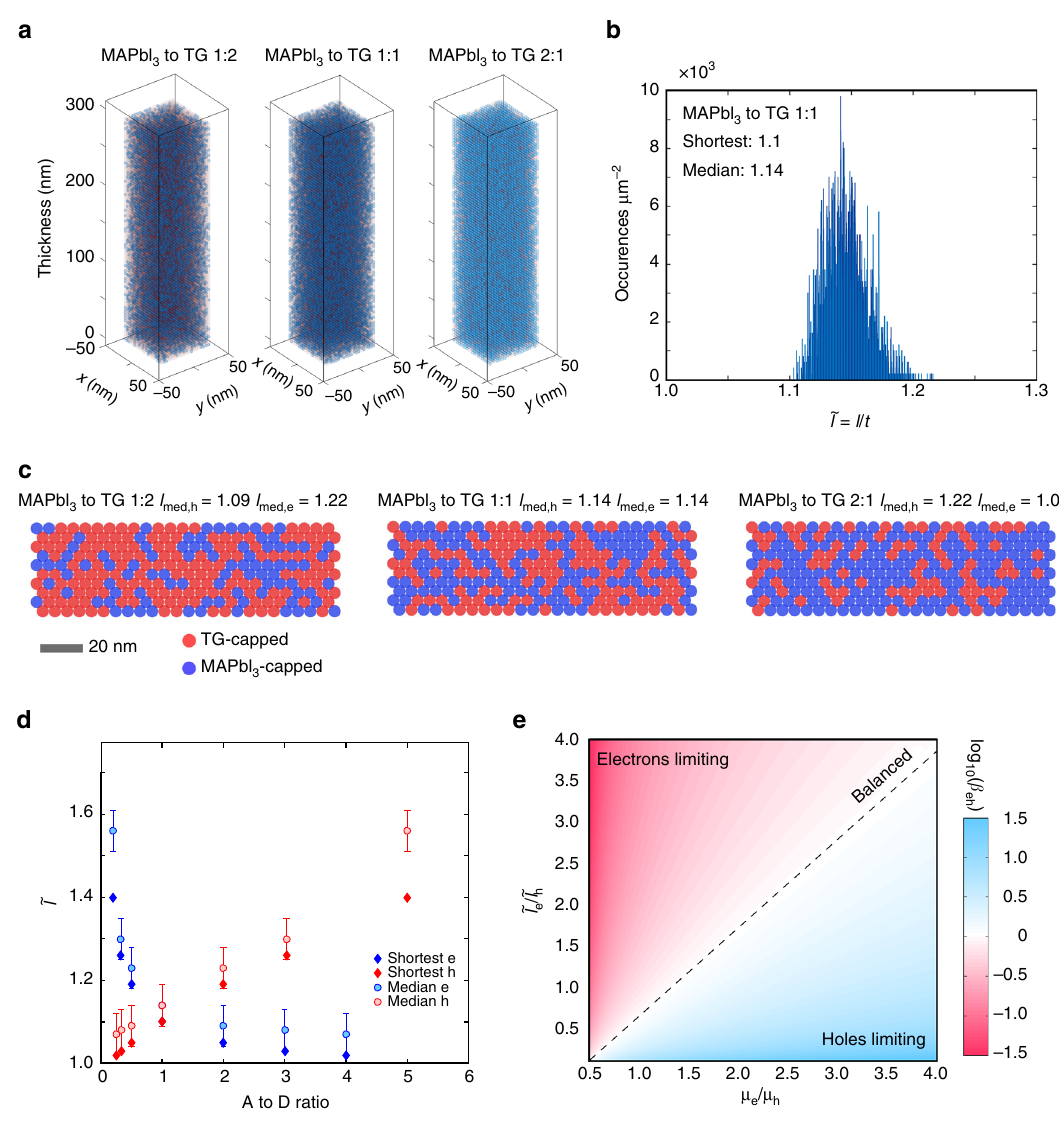
Fig. 3 Morphology of the mixed-quantum-dot structure for balanced carrier extraction. a Cross-section of a mixed fi lm with different QD donor/acceptor ratios. Blue and red spheres represent acceptor and donor QDs, respectively. b Distribution of path lengths for a 1:1 A- to D-type QD ratio. For this con fi guration, the shortest path (normalized to thickness) is 1.1, and the median length of 1.14. c Slices of mixed CQD solids with different D/A ratios representing the dominant presence of each type of QD. d Normalized path length as a function of A- to D-type QD ratio within a mixed QD fi lm. Error bars represent the standard deviation of the 10 shortest different path lengths for each A/D con fi guration. e Balanced extraction ( β = 1) requires a compromise between electron and hole mobilities and their respective path-lengths. A maximum power conversion ef fi ciency is expected when the carrier extraction is balanced (Supplementary Fig.